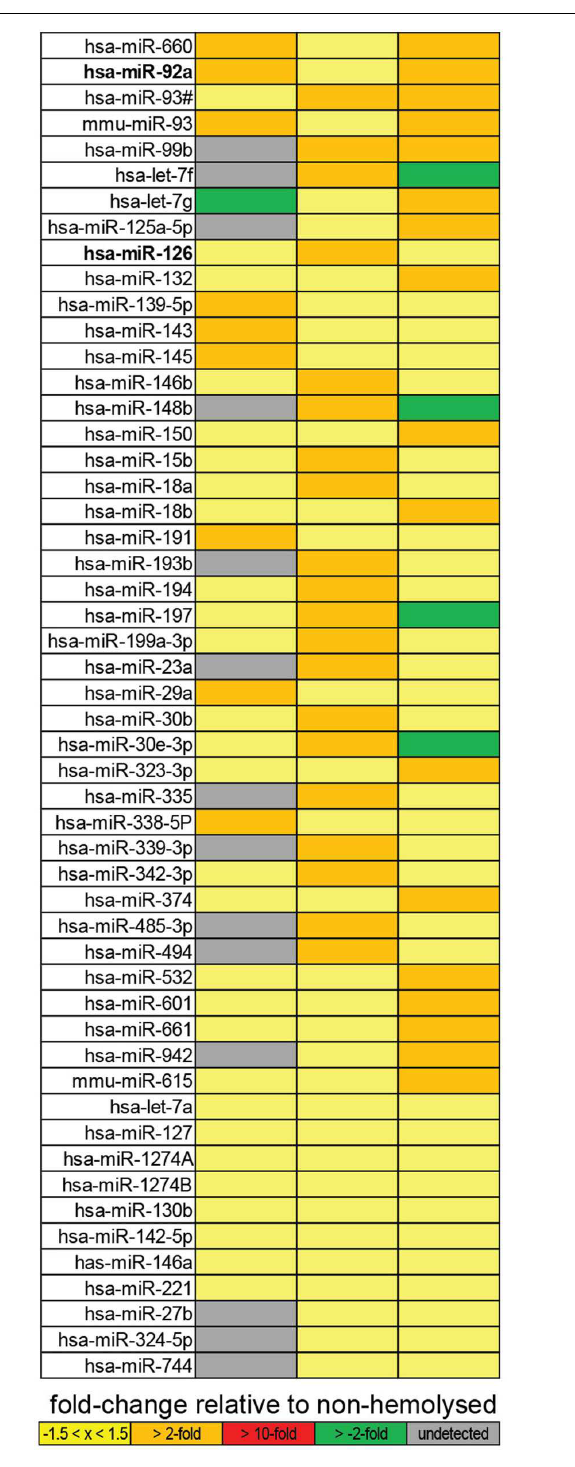
FIGURE 2 | Overview of microRNAs identified as being elevated in hemolyzed plasma or unaffected by hemolysis .The top 15 microRNAs are elevated in the hemolyzed sample of all three pairs, the following 37 microRNAs are elevated in two of the three pairs followed by the 36 microRNAs elevated in just one pair.The 11 microRNAs at the bottom of the list represent those with less than ± 1.5-fold difference between the hemolyzed and non-hemolyzed